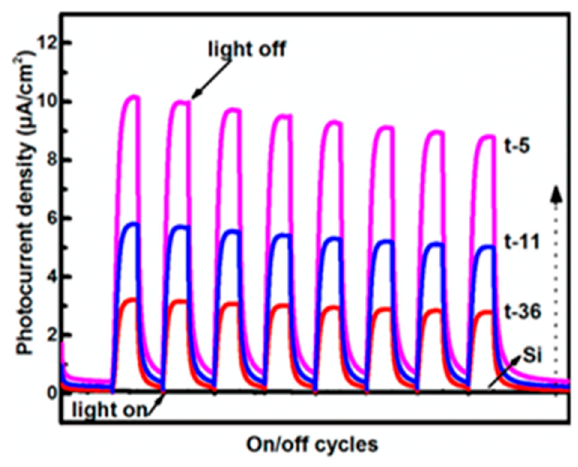
Figure 7. Photocurrent response (0.4 V bias) of selected catalysts and Si substrate electrodes in 1 mol · L − 1 Na 2 SO 4 under visible-light illumination and in dark where t-5, t-11, and t-36 represents catalysts with an average film thickness of 0.28, 0.79, and 2.26 µ m, respectively [9]. Reprinted with permission from ref. [9].